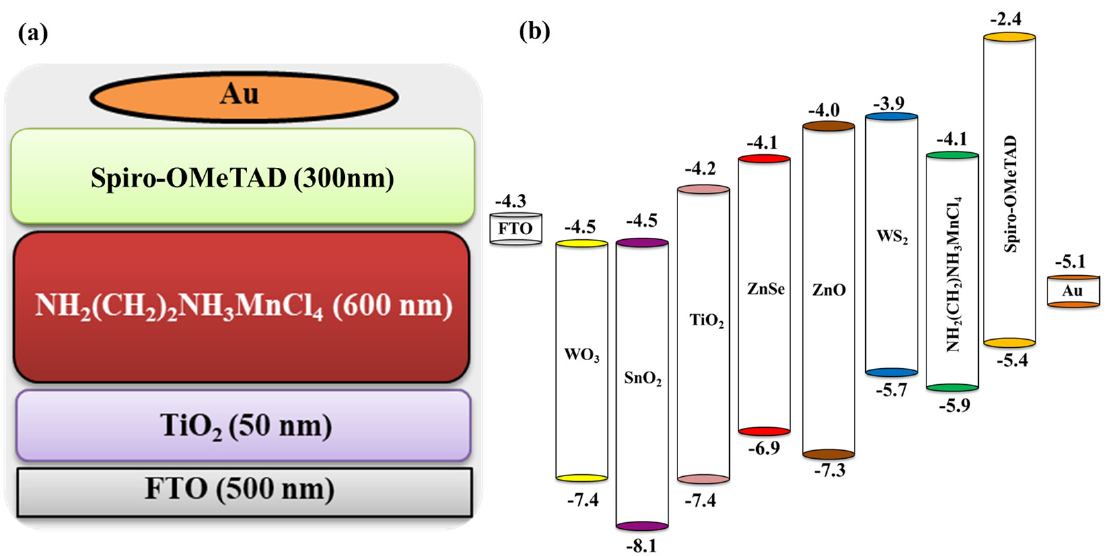
Scheme 1. Pictorial representation showing device structure ( a ) and energy level; ( b ) diagram of PSCs.